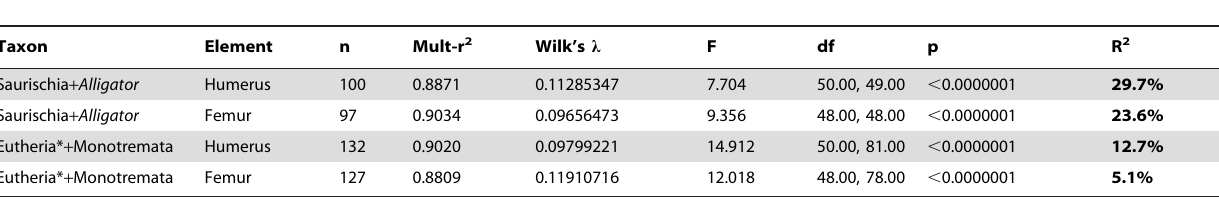
Table 4. Multiple and multivariate regression of partial warps on size (humerus or femur maximum